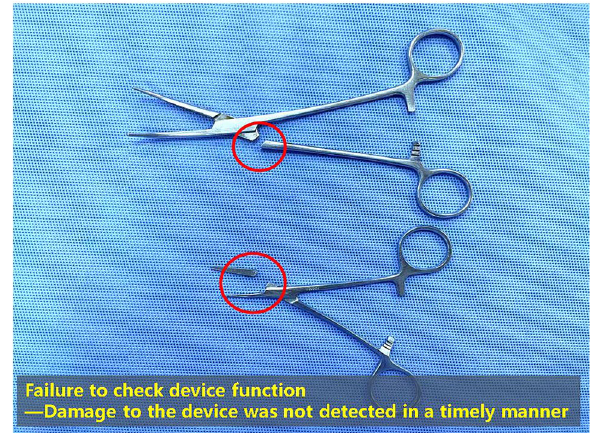
Figure 2. Failure to check device function.